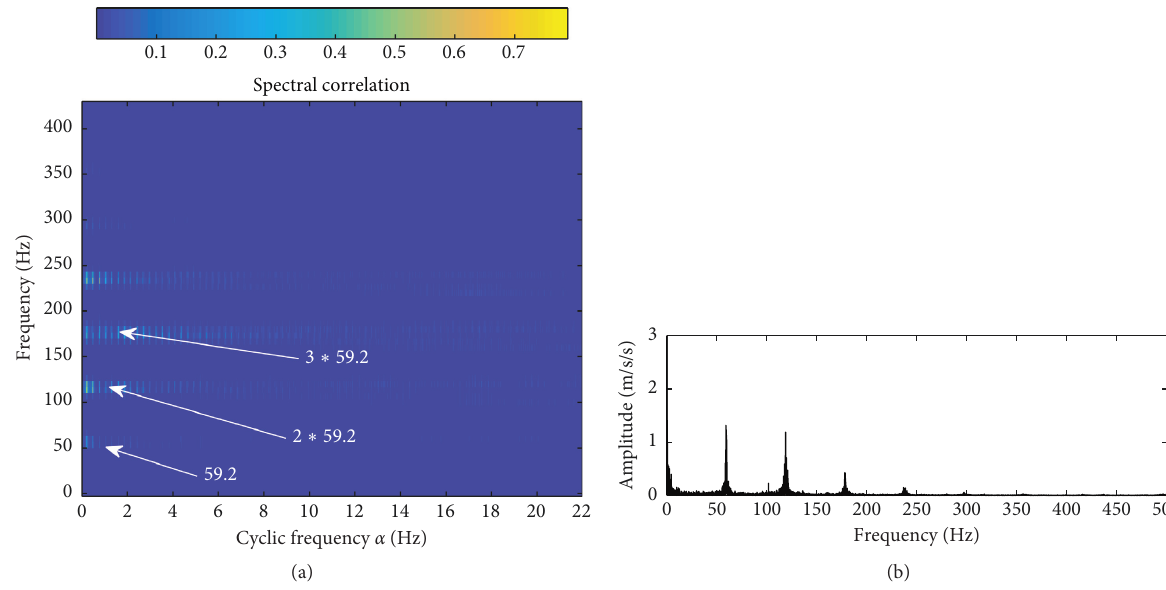
Figure 14: FSC image and EES of the reconstructed gear signal: (a) FSC image of the reconstructed gear signal by using the learned atoms as shown in Figure 13; (b) EES of the reconstructed gear signal by using the obtained FSC image as shown in Figure 14(a).